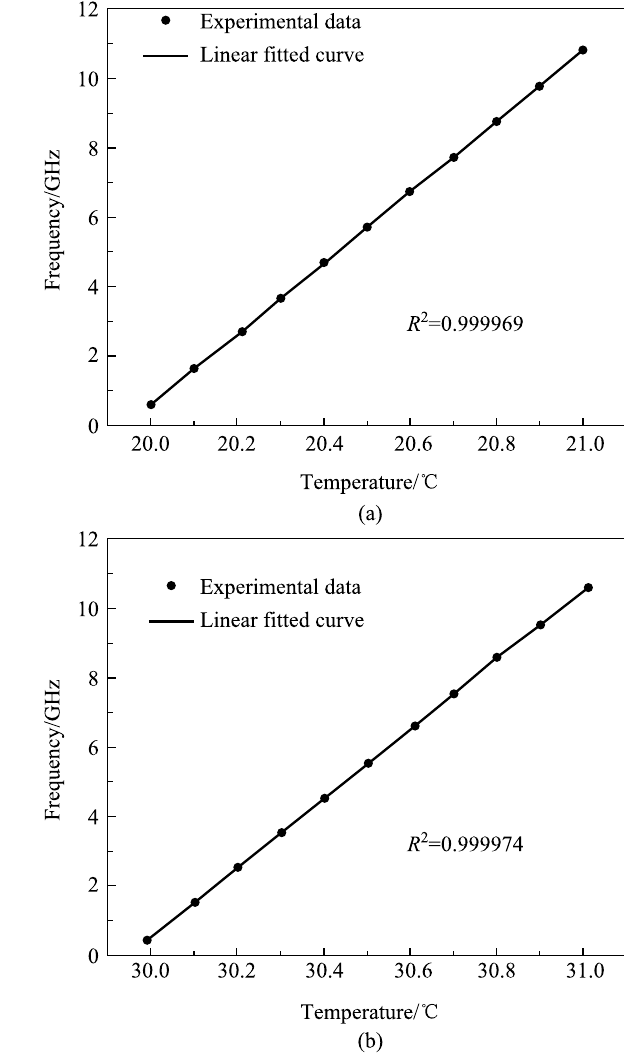
Fig. 6 Experimental results of the proposed MPF-based temperature sensor. a Measured responses of the MPF at different temperatures. b Measured center frequencies of the MPF versus temperature and the linear fitted curve of the experimental data